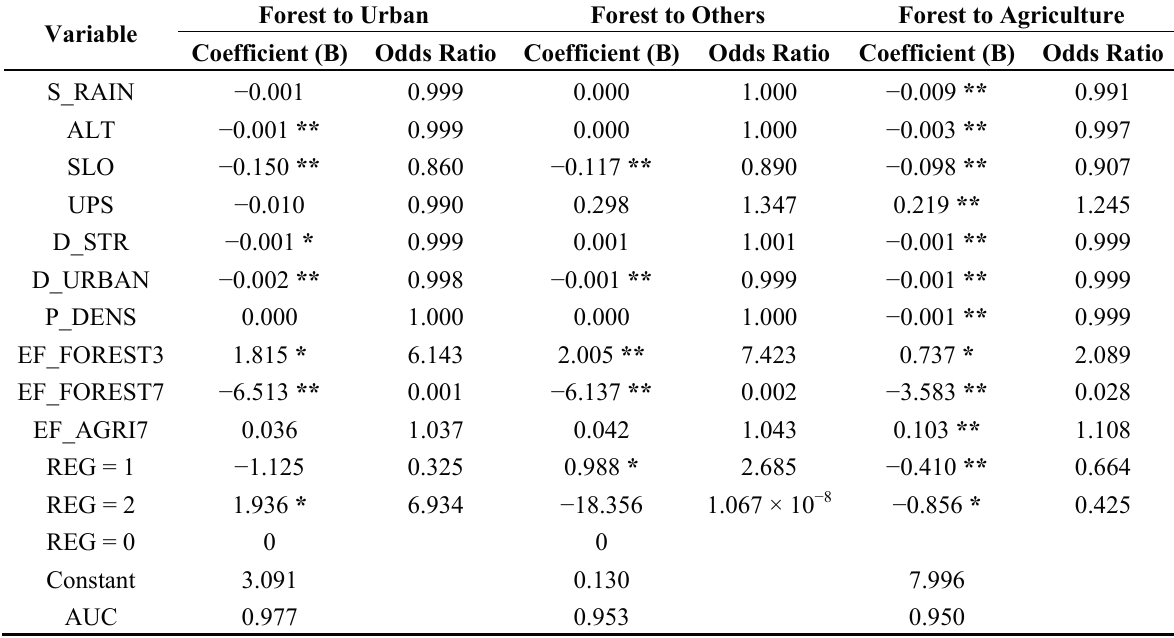
Table 5. Factors of forest land-use changes using logistic regression (1980~1990).